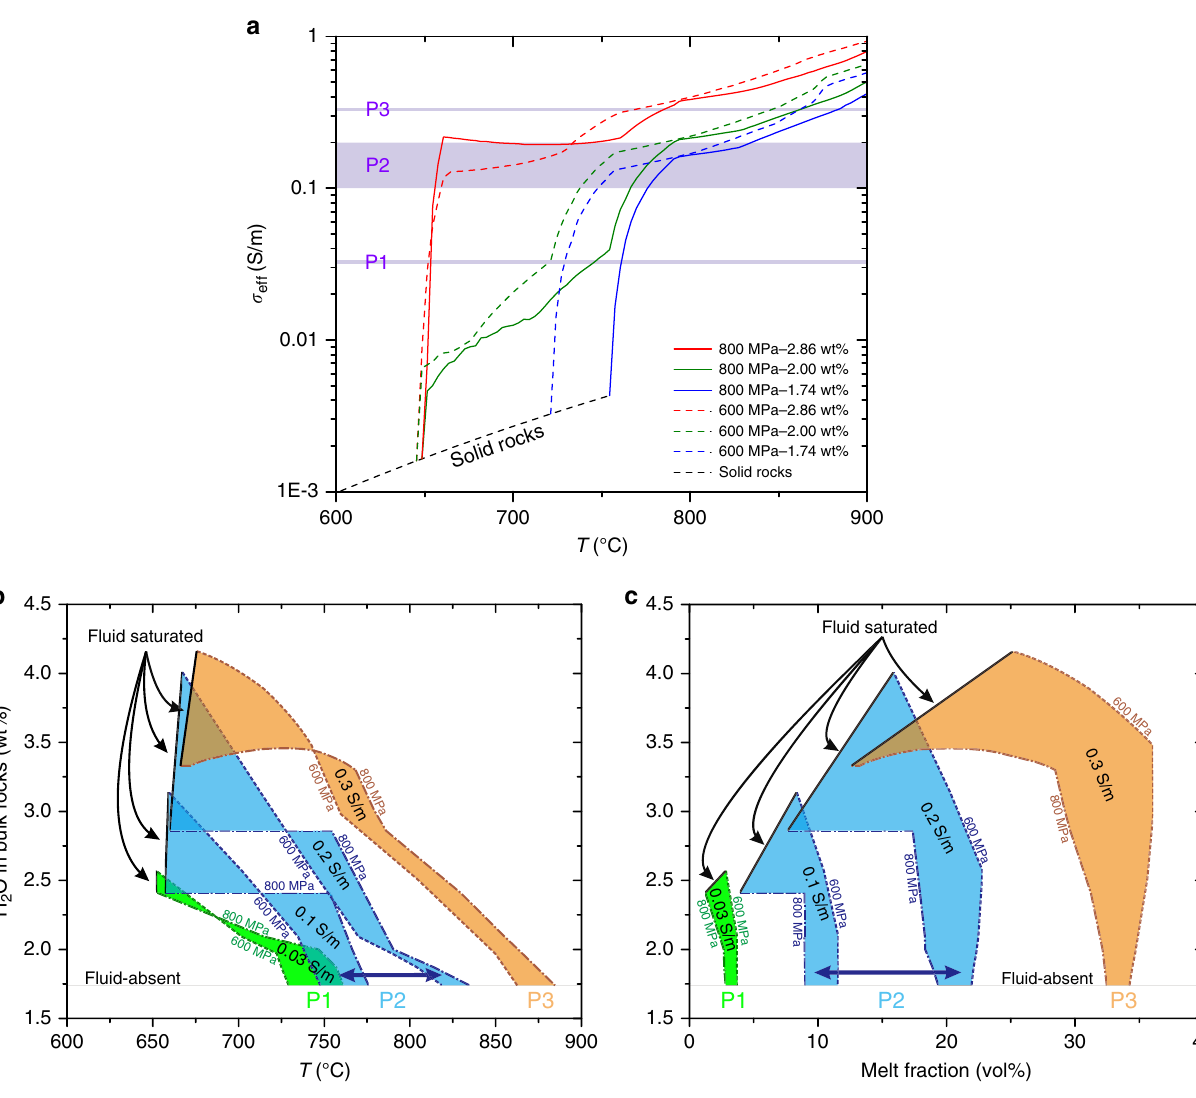
Fig. 4 Melting, H 2 O, temperature, melt fractions, and the multiple solutions explaining the electrical anomalies beneath Tibet. a Relationship between σ eff and temperature with different H 2 O content in the bulk rock at 600MPa (dashed lines) and 800 MPa (solid lines). The black dashed line refers to the solid rock before melting starts. b , c Range of temperatures ( b ) or melt fractions ( c ) and H 2 O bulk rock contents satisfying the conductivity of 0.03 S/m (P1), 0.1 – 0.2 S/m (P2), and 0.3 S/m (P3), respectively. The boundaries of fl uid-absent and fl uid-saturated magmas identi fi ed by black straight lines con fi ne